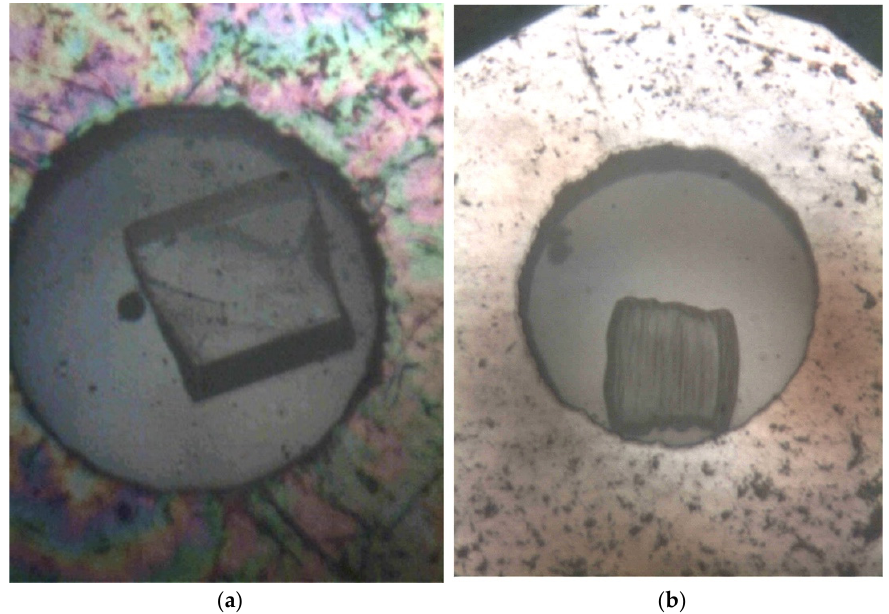
Figure 2. A Z-DNA d(CGCGCG) 2 crystal in the DAC chamber seen at ambient pressure, ( a ) before and ( b ) after pressurization at 1 GPa. Although optically strongly affected by the compression cycle and the data collection, the crystal in ( b ) was still diffracting to 2.5 Å resolution when they initially diffracted up to 1.1 Å at ambient pressure. diffracted up to 1.1 Å at ambient